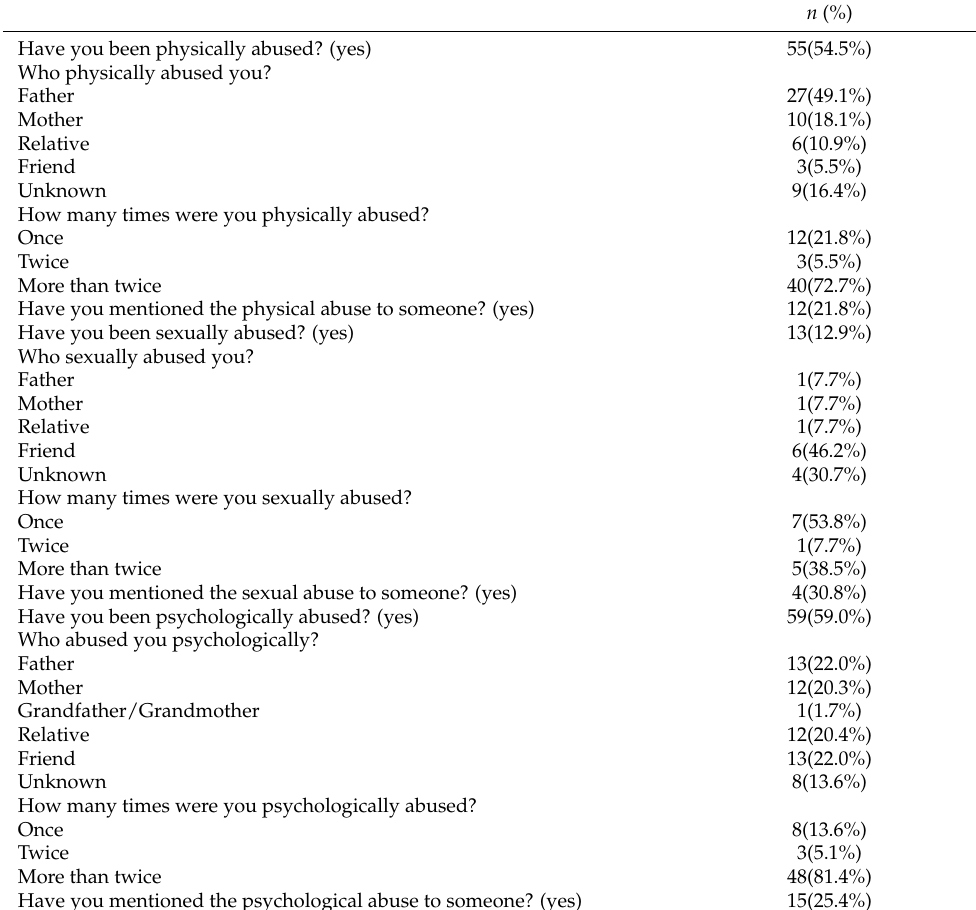
Table 4. Distribution of the sample according to abuse before imprisonment ( n = 101).